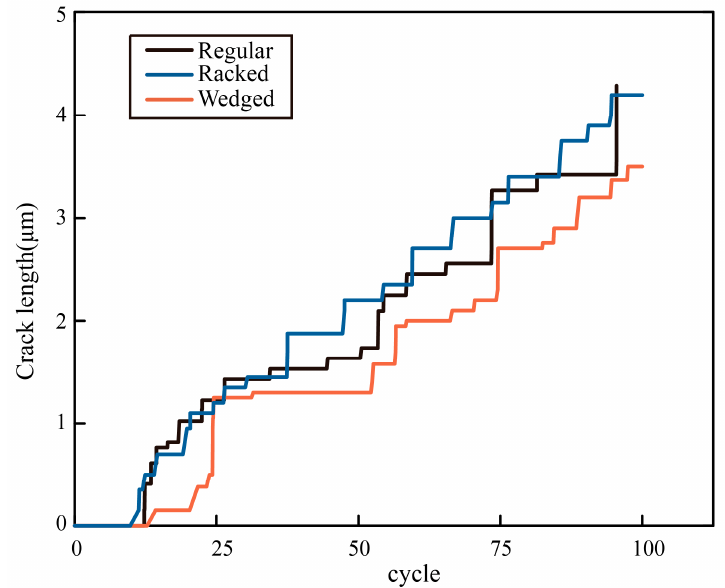
Figure 7. Crack growth curves corresponding to different morphological models.